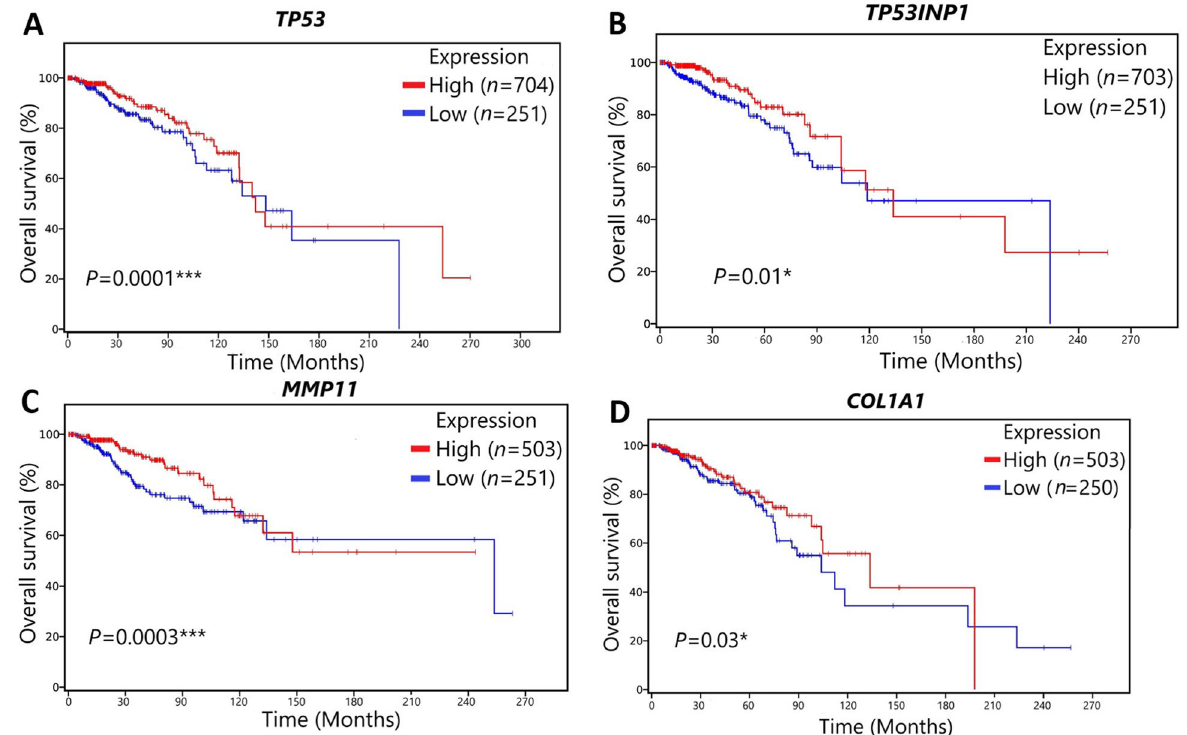
Figure 5. The significant effect of the expression value of target genes ( TP53 , ( A ) , TP53INP1 ( B ), ( C ), MMP11 and COL1A1 ( D )) on patient with BC by the Kaplan–Meier survival curves shows that patients with BC were split into 2 classes according to their expression